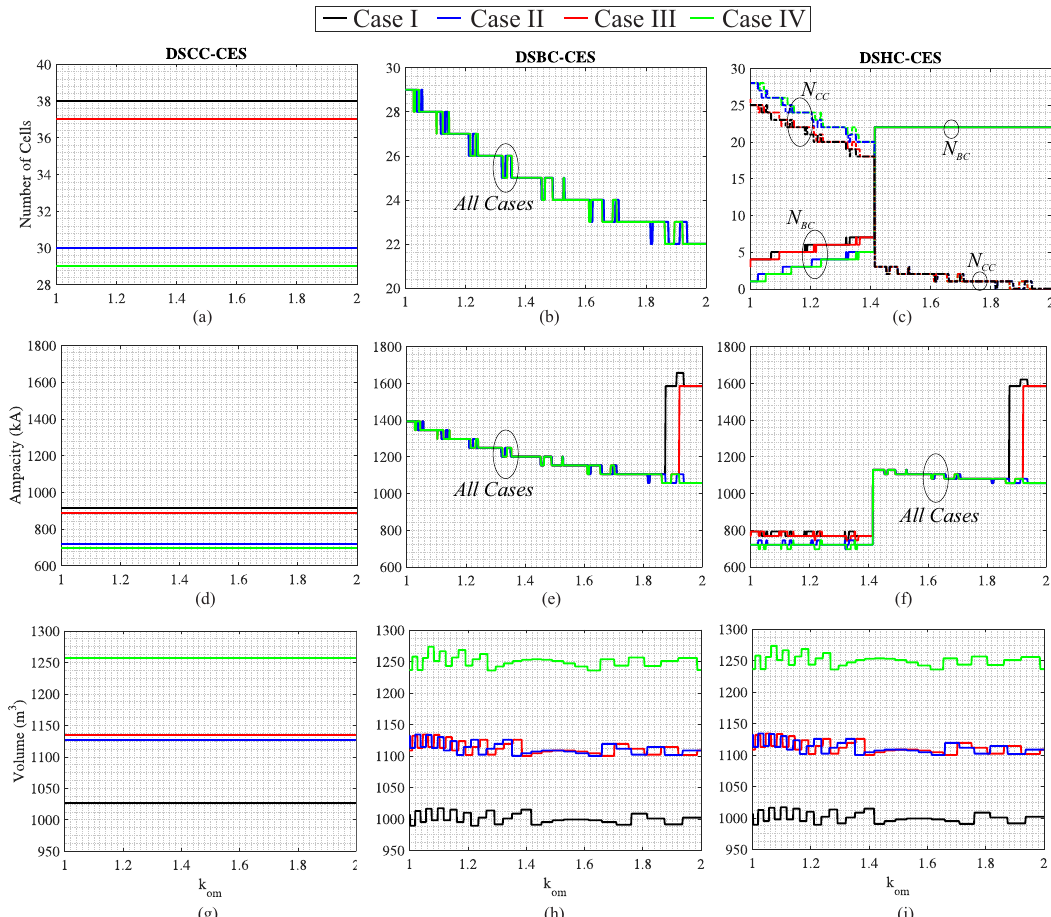
Figure 8. Effects of the allowed SOC range in the ES-STATCOM parameters for CES topologies: ( a ) Number of cells for DSCC-CES. ( b ) Number of cells for DSBC-CES. ( c ) Number of cells for DSHC-CES. ( d ) Converter ampacity for DSCC-CES. ( e ) Converter ampacity for DSBC-CES. ( f ) Converter ampacity for DSHC-CES. ( g ) Volume of batteries for DSCC-CES. ( h ) Volume of batteries for DSBC-CES. ( i ) Volume of batteries for DSHC-CES.